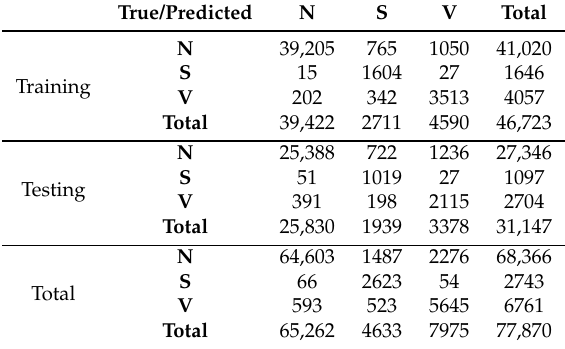
Table 3. Confusion matrices relative to beat classifications (normal (N), supraventricular (S), and ventricular) for the training, testing, and total